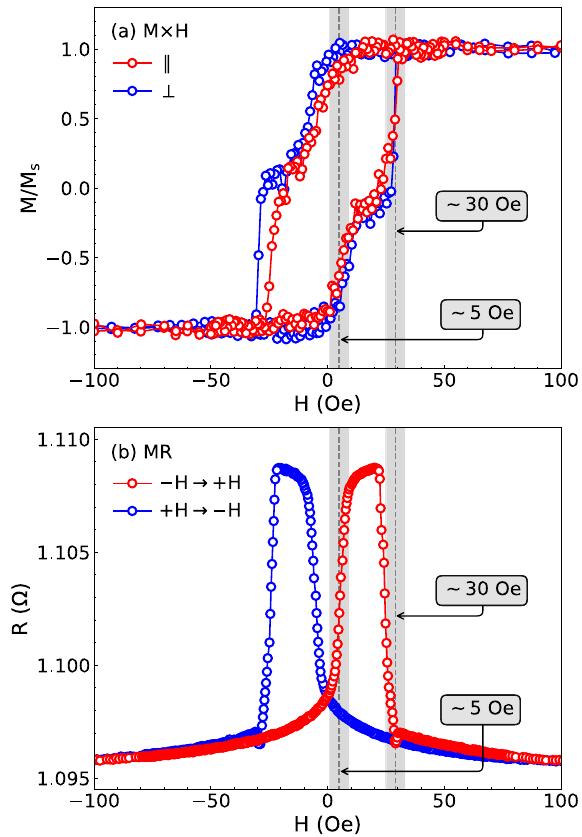
Figure 2. ( a ) Normalized magnetization and ( b ) magnetoresistance curves for our NiFe/Cu/Co film with t 10 nm. The magnetization curves are measured with in-plane magnetic field applied along (red) and Cu = perpendicular (blue) to the main axis of the sample. The magnetoresistance curve is acquired with the electrical current applied along the main axis, and the color code represents the responses obtained in the two branches of the hysteresis loop, with increasing (red) and decreasing (blue) fields. The gray zones indicate the regions of magnetization reversion of the NiFe layer at low field and of the Co one at higher field in the branch of the hysteresis loop with increasing field from the maximum negative value. Specifically, for the film with t 10 nm, they are found at 5 and 30 Cu = ∼ ∼